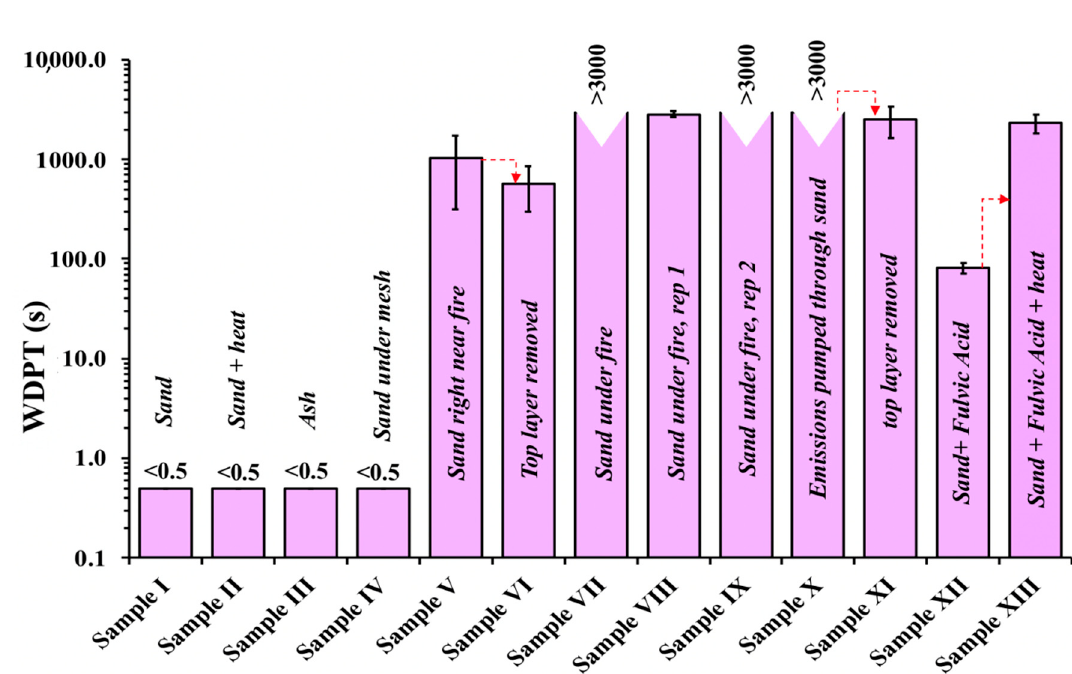
Figure 1. Water droplet penetration time (WDPT) for 13 analyzed samples. Units = seconds (s).